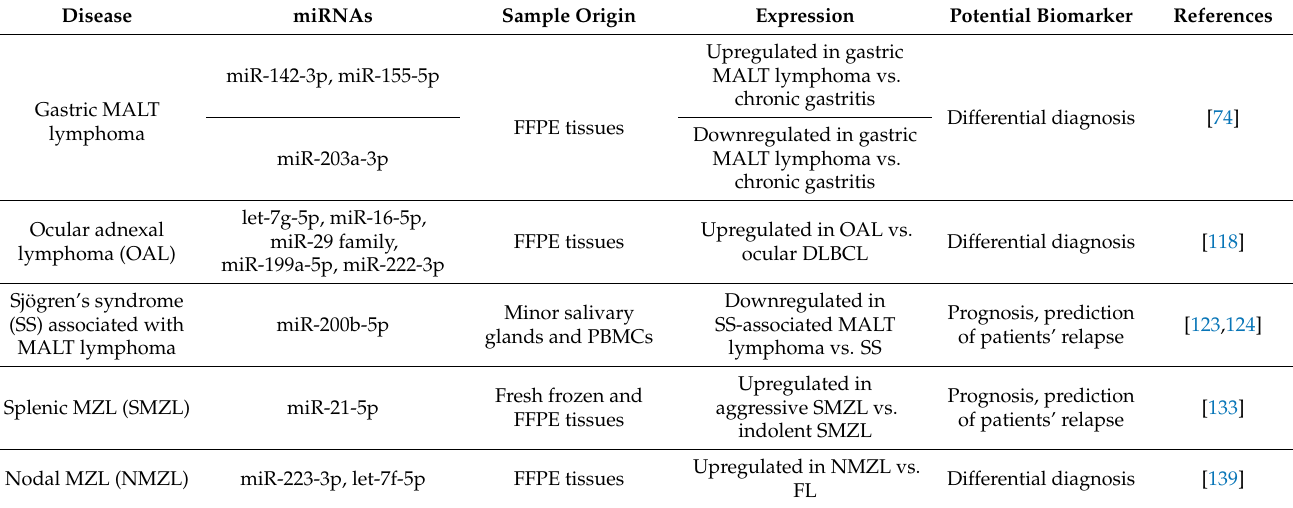
Table 3. miRNAs as candidate biomarkers in marginal zone lymphoma